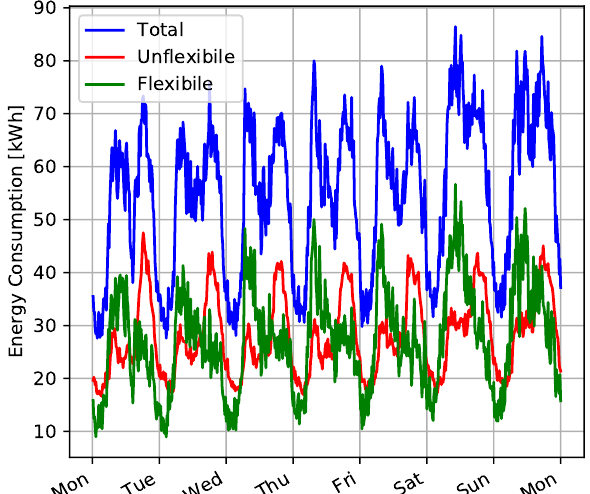
Figure 7. Total, flexible, and inflexible power consumption during a sample week in the NEEA’s RBSA